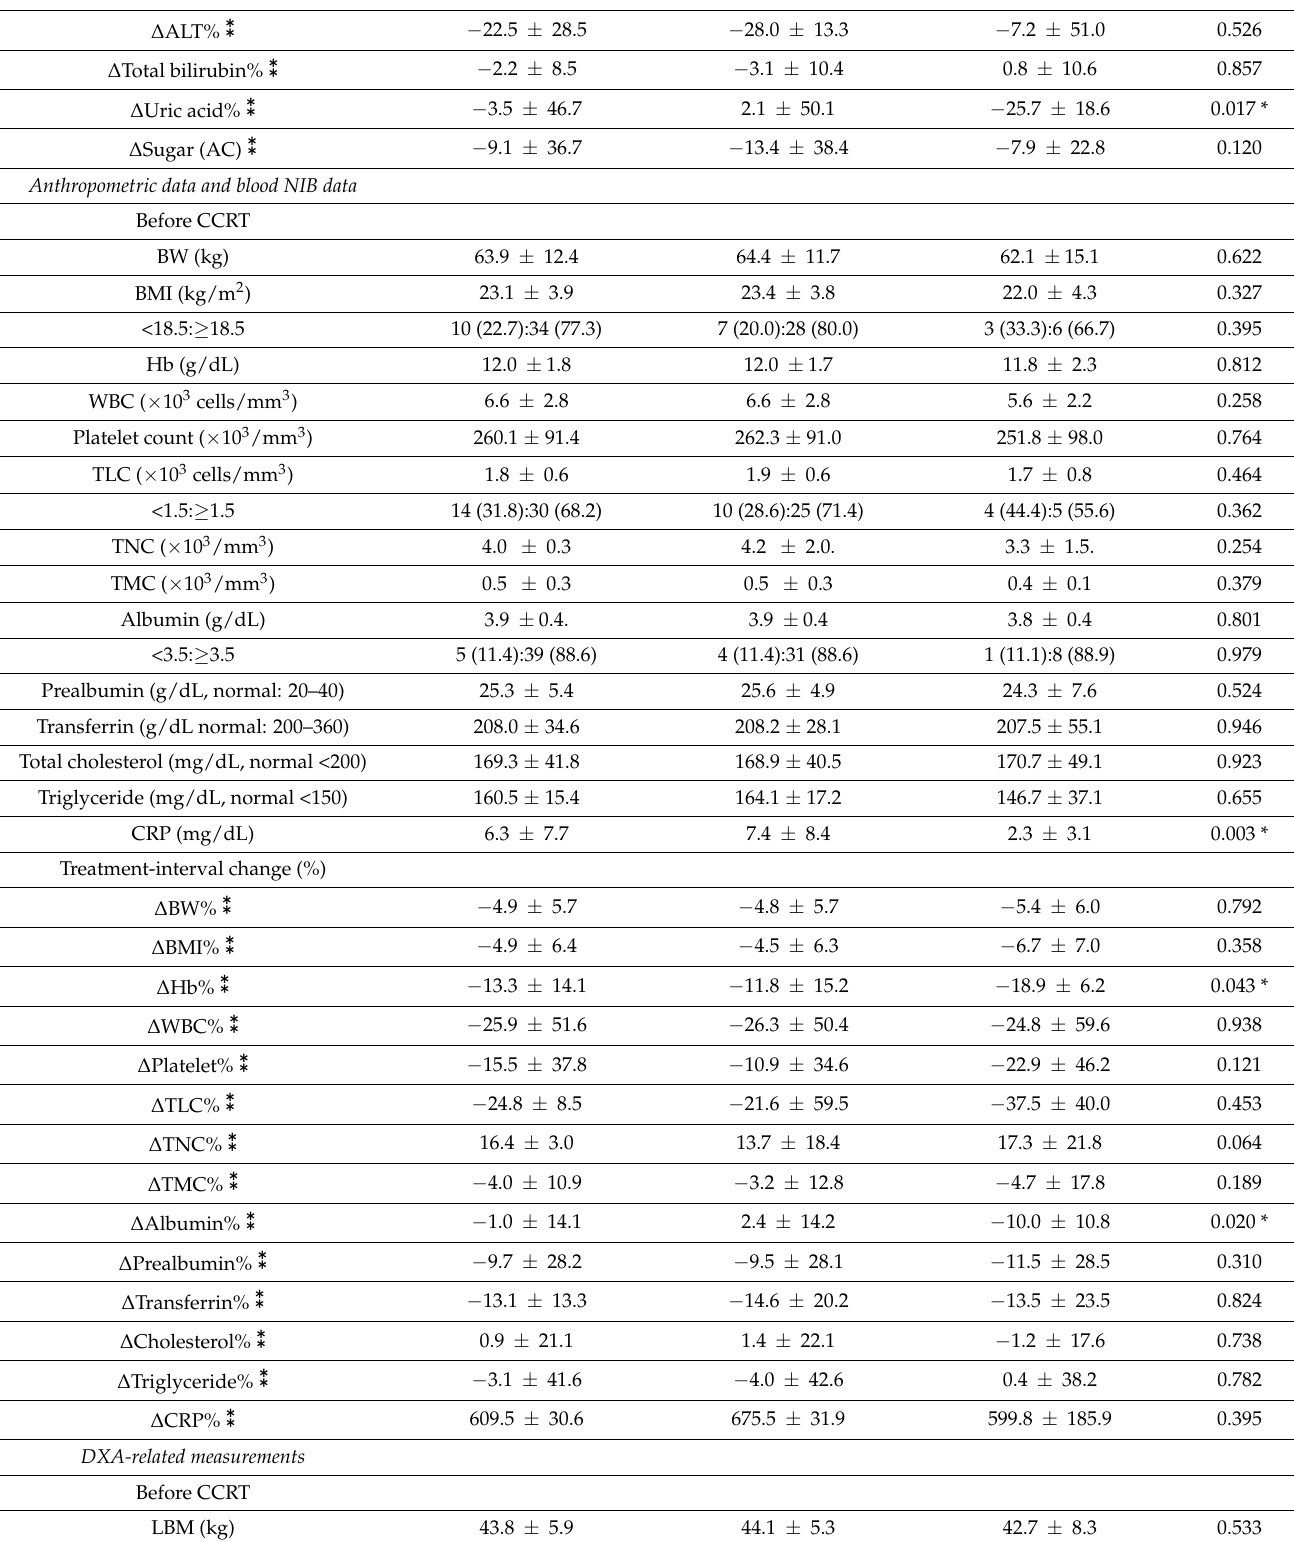
Table 1. Clinicopathological variables, biochemical and nutrition–inflammation data, anthropomet- ric and body composition characteristics, serum HLOP metabolites, and treatment-related factors of 44 patients with LAHNSCC completing the CCRT course, stratified by treatment interruption.